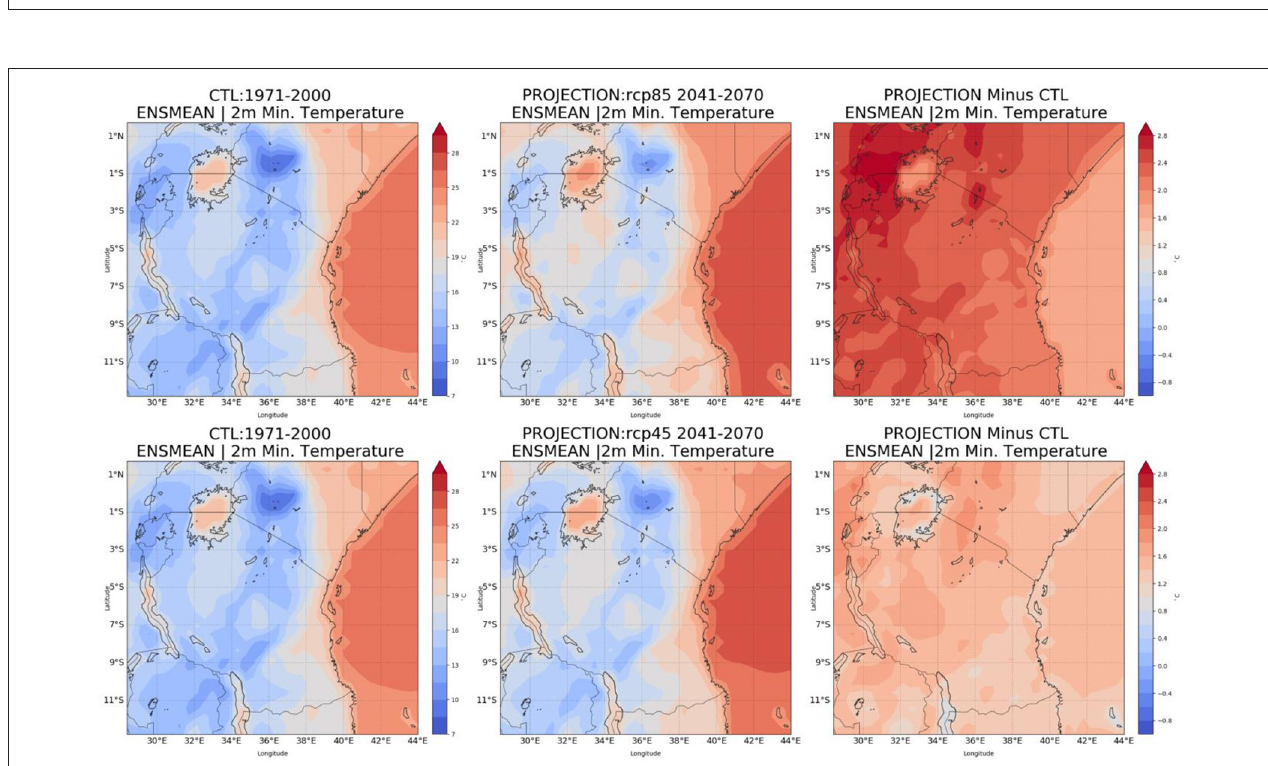
FIGURE 7 | The average of minimum temperature during base period (1971–2000), mid century (2041–2070), and the change in temperature during present century under both RCP8.5 (upper) and RCP 4.5 (lower) .